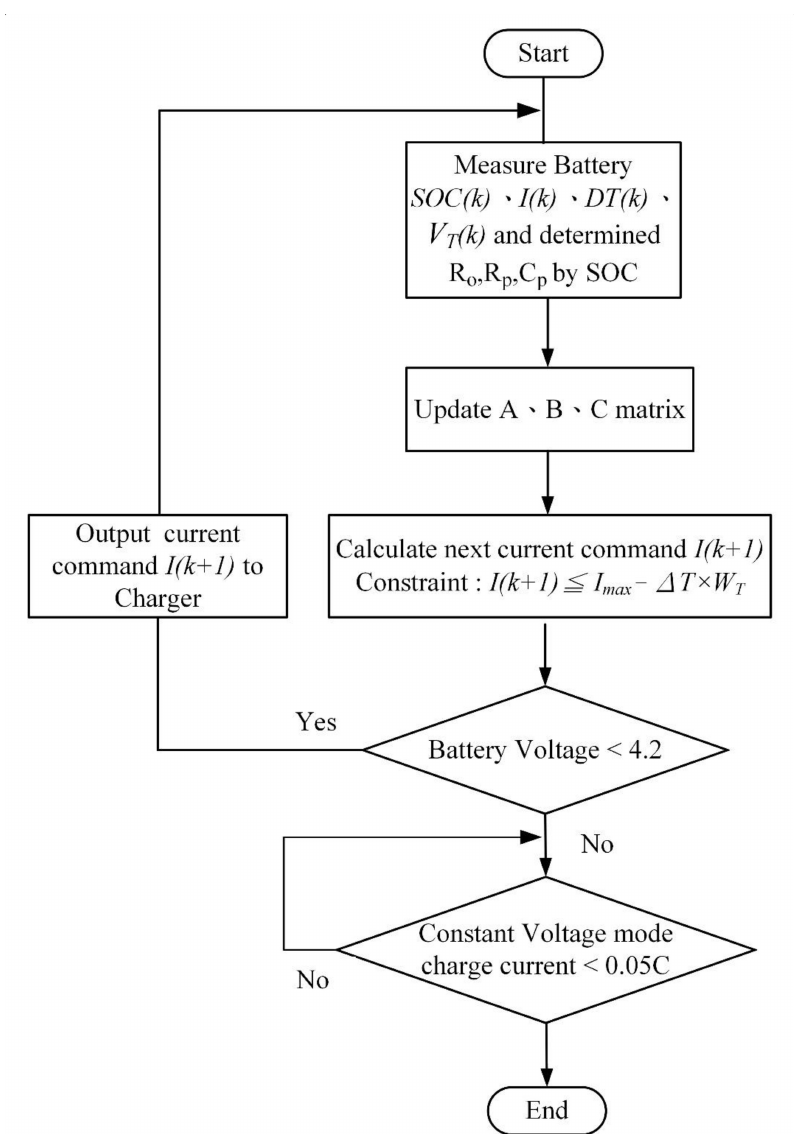
Figure 9. Flowchart of the proposed MPC charging